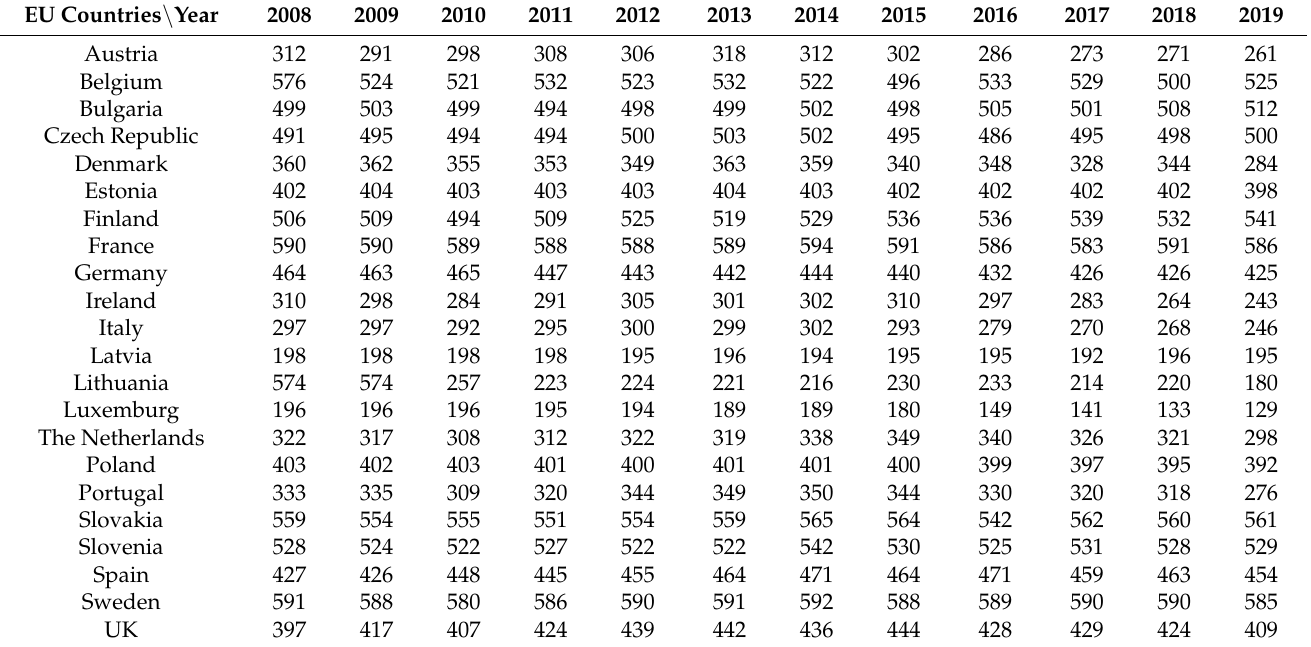
Table 3. Environmental footprint (m 2 /kWh) of electricity production in EU